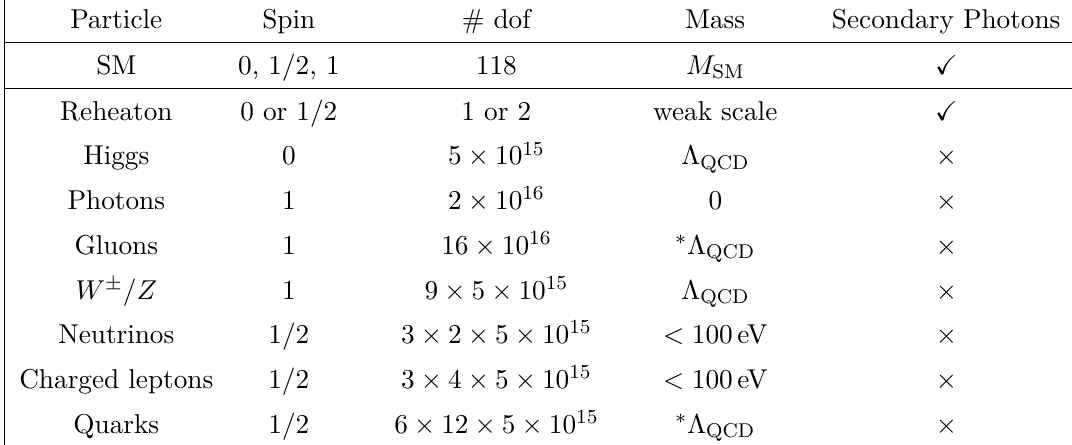
× denotes QCD , see QCD